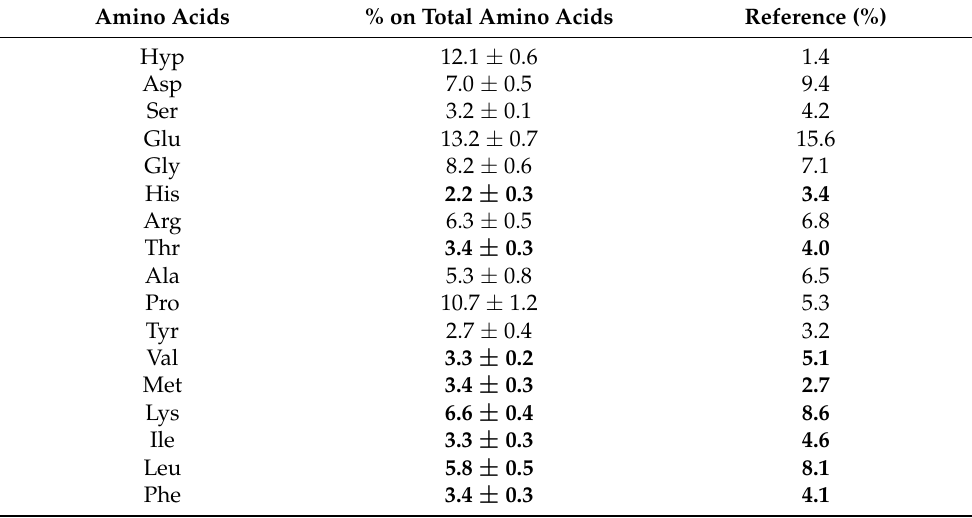
Table 1. High-performance liquid chromatography with fluorescence detection (HPLC-FLD) analysis of amino acid distribution in initial calf fleshing by-products given as percentage of the total amino acid